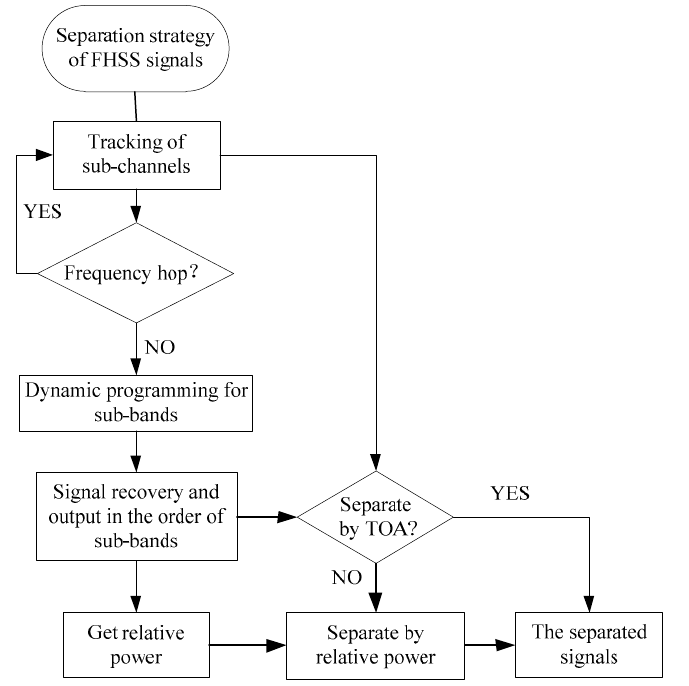
Figure 4. Separation strategy of frequency hopping (FH) signals.